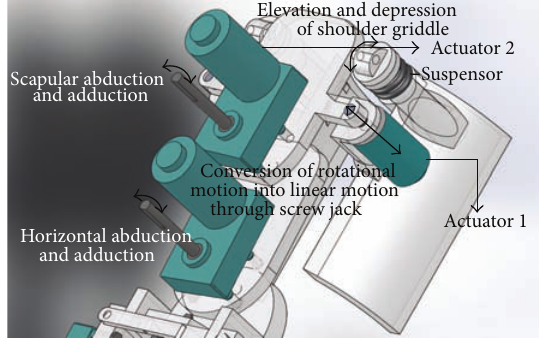
Figure 3: Shoulder griddle joint model.